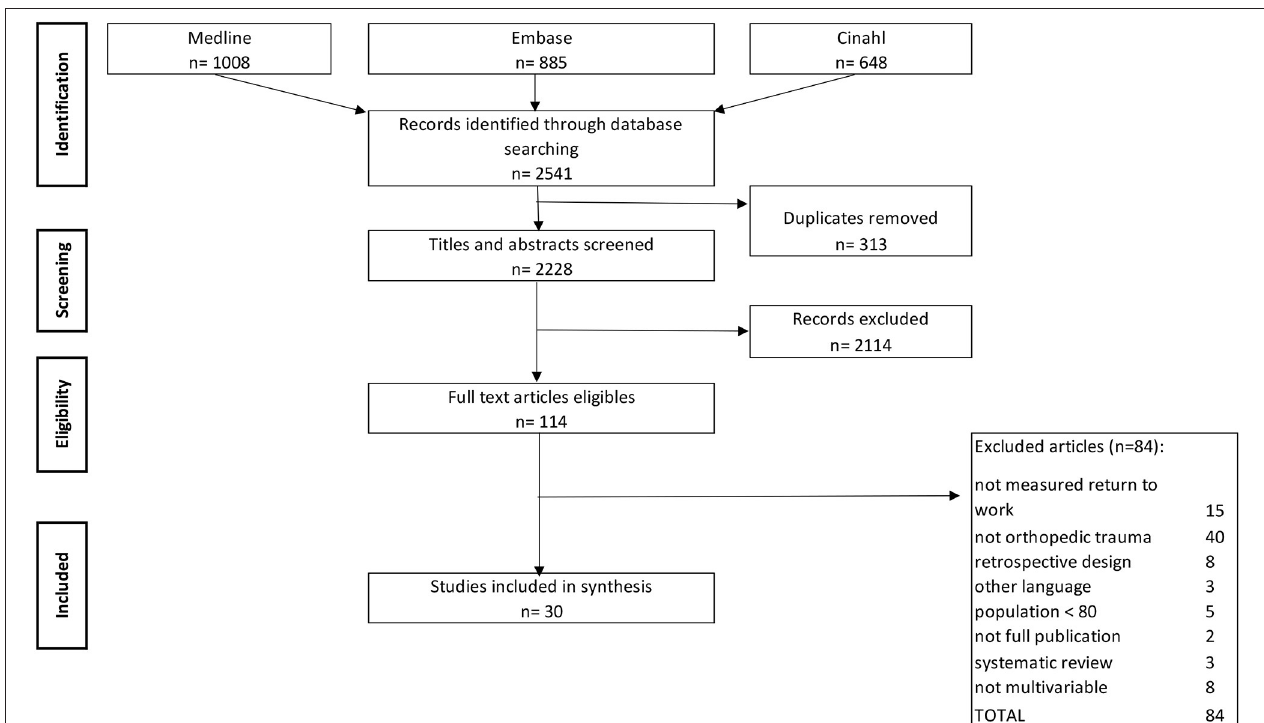
FIGURE 1 | Flow diagram for selection of studies for this systematic